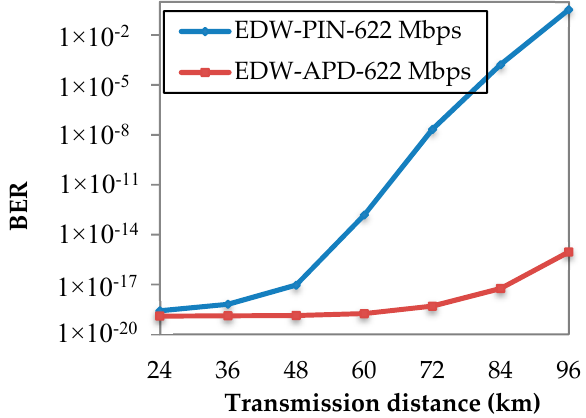
Figure 6. BER with transmission distance of SAC-OCDMA system using EDW codes using two different detectors in presence of DCF.